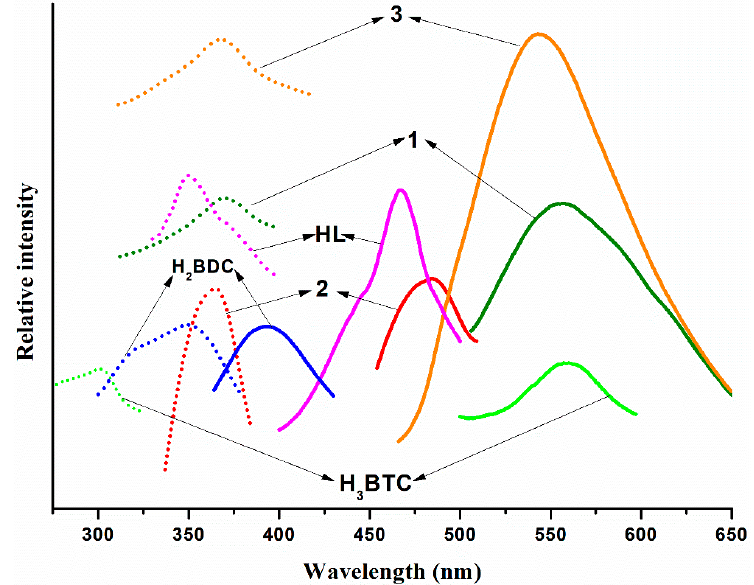
Figure 14. Excitation and emission spectra of the three polymers—dot symbol (EX) and solid symbol (EM).